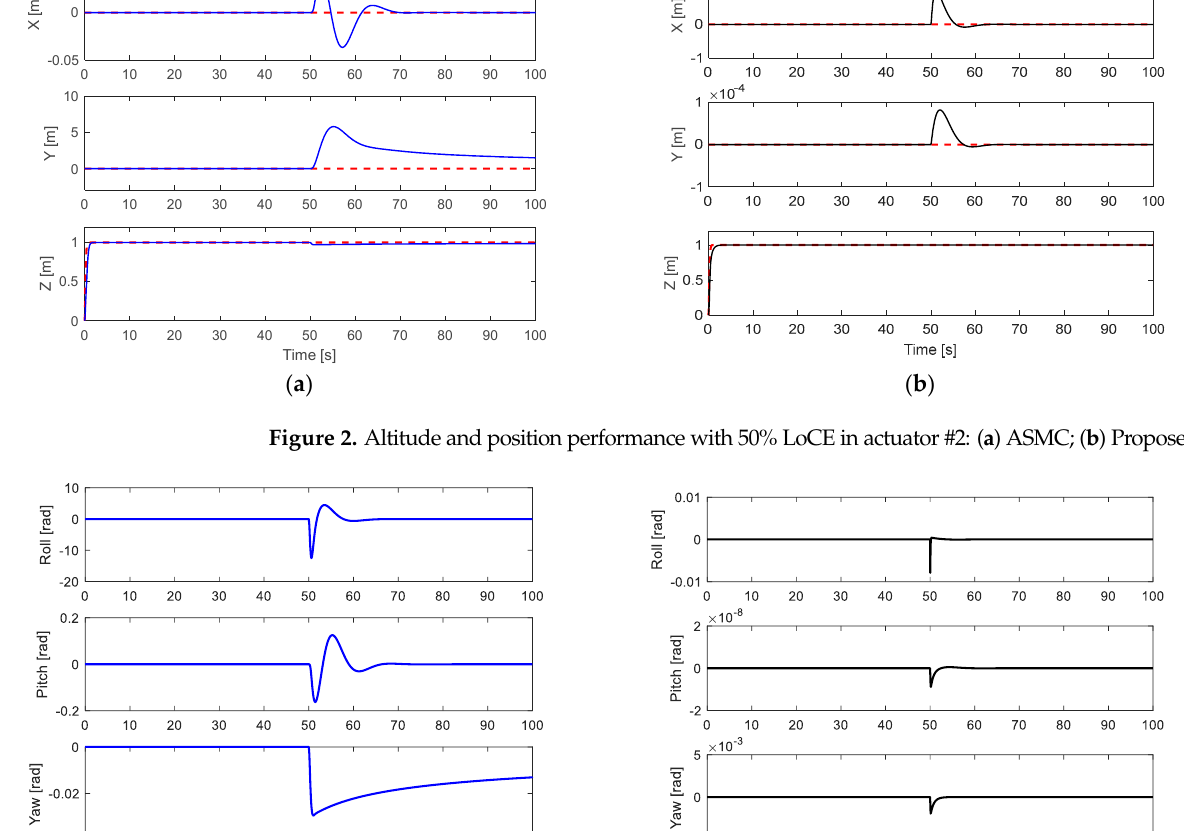
( b ) Figure 3. Attitude angle performance with 50% LoCE in actuator #2: ( a ) ASMC; ( b ) Proposed FTC.